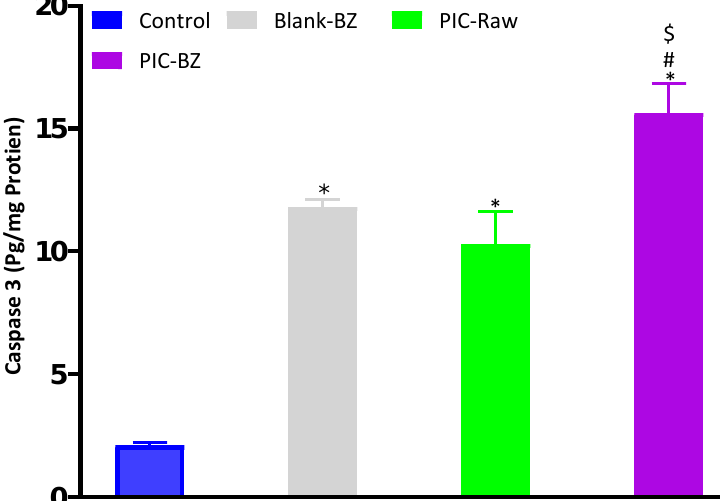
Figure 9. Effect of Blank-BZ, PIC-raw, or PIC-BZ treatments on caspase-3 enzyme contents in A549 cells. Values are expressed as pg/mg of protein. Data are the mean of 4 independent experiments ± SD. * Significantly different from control, p < 0.05; # significantly different from Blank-BZ, p < 0.05; $ significantly different from PIC-raw, p < 0.05.